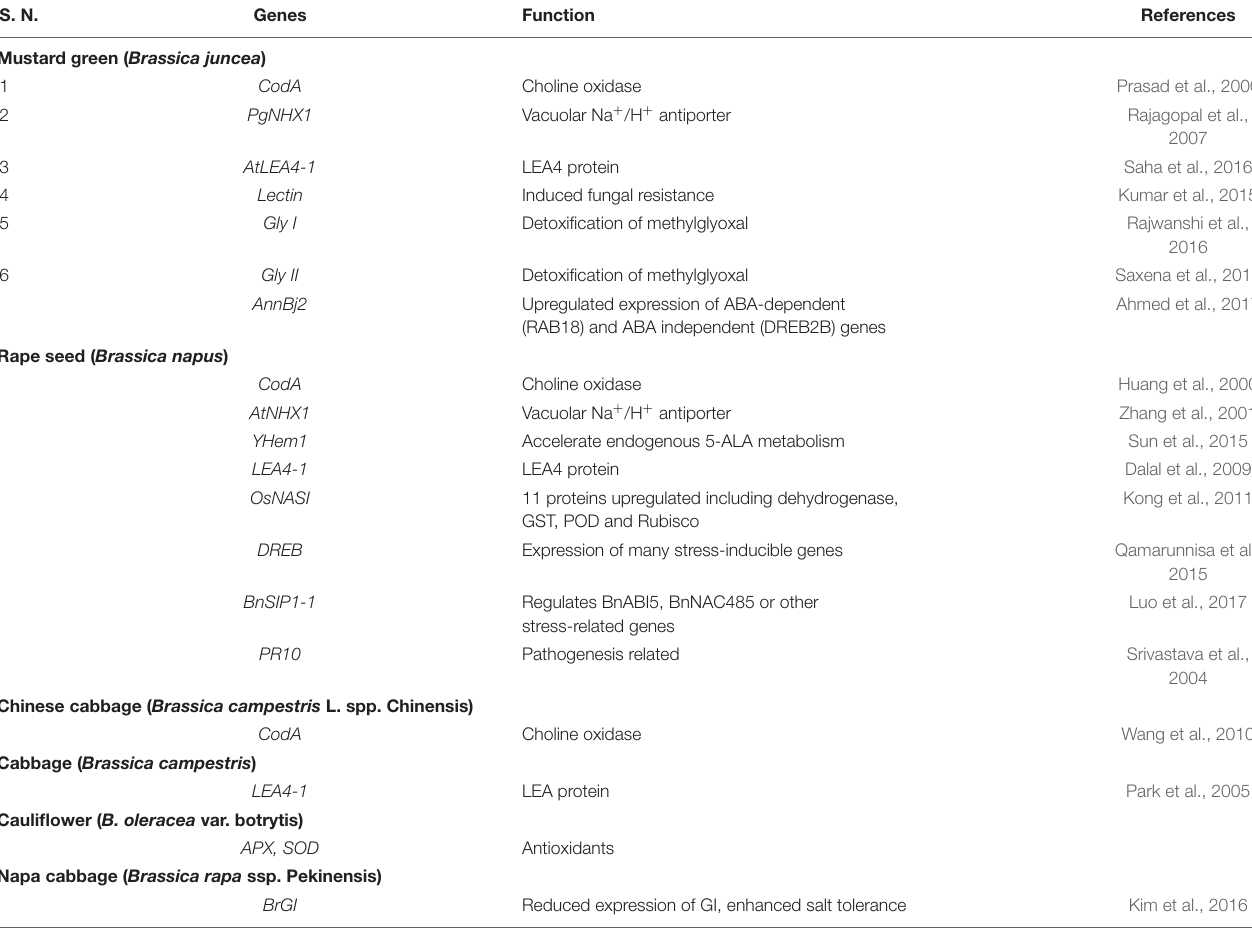
TABLE 3 | Transgenic crops developed in cole crops for salt stress tolerance. S.